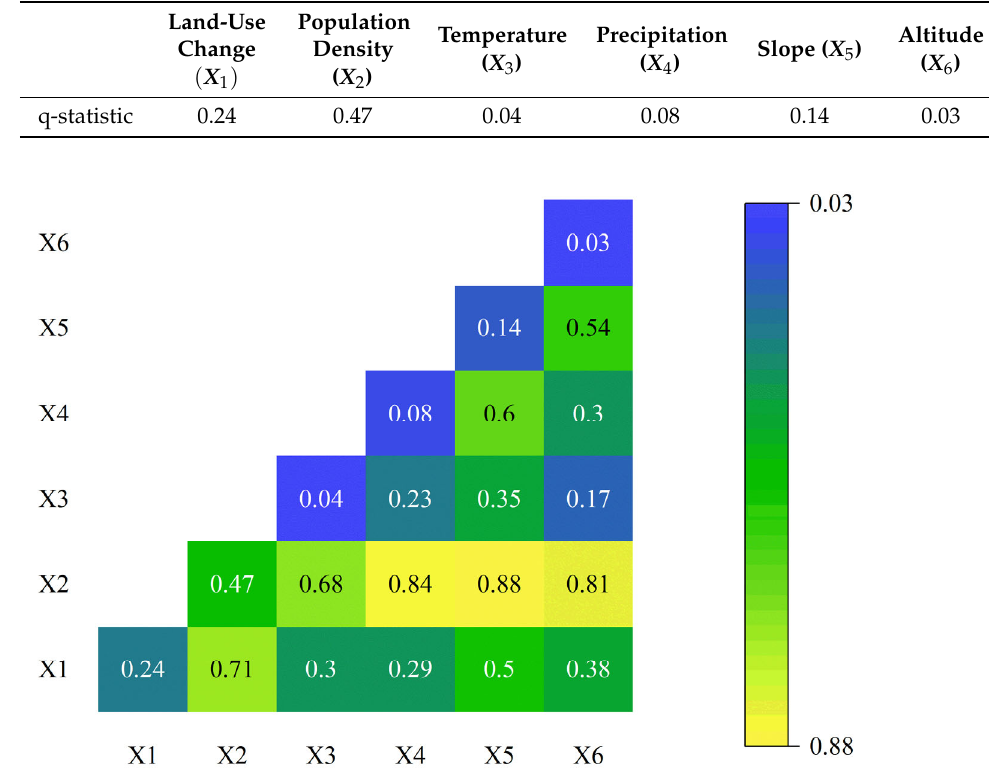
Figure 9. Interaction detection